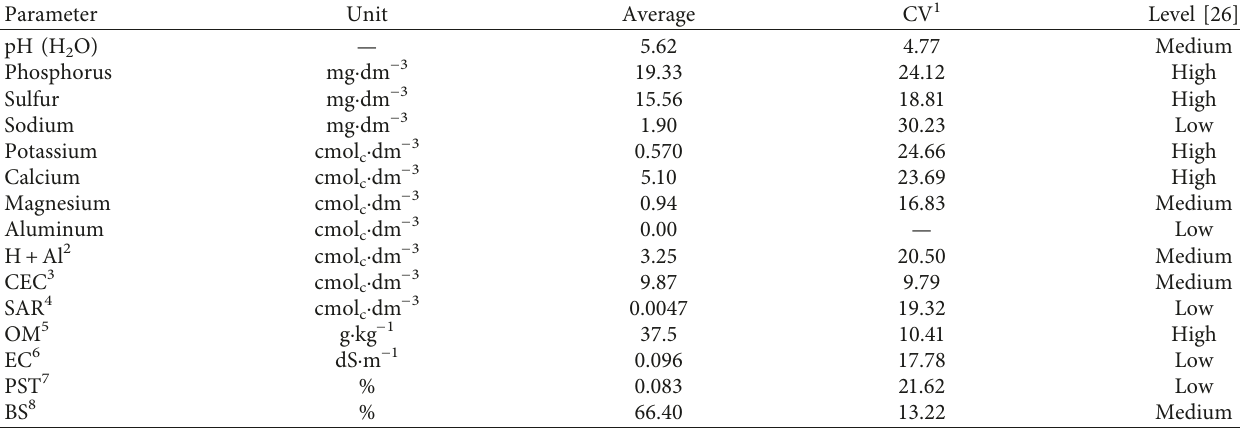
Table 2: Chemical analysis of the soil from the experimental area in the layer 0–0.20 m before conducting the experiment. Parameter Unit Phosphorus Potassium Calcium